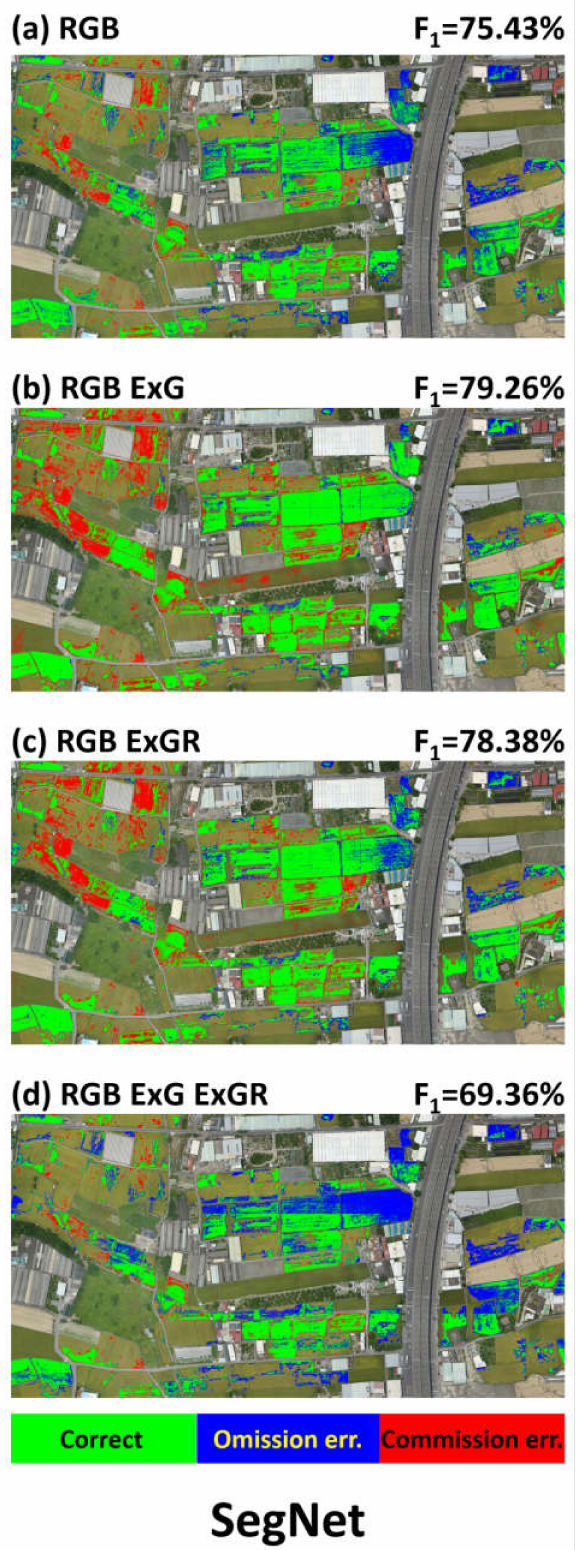
Figure 13. Results of SegNet identification for rice lodging on 2017 testing dataset using various spectrum information: ( a ) RGB, ( b ) RGB + ExG, ( c ) RGB + ExGR, and ( d ) RGB + ExG +